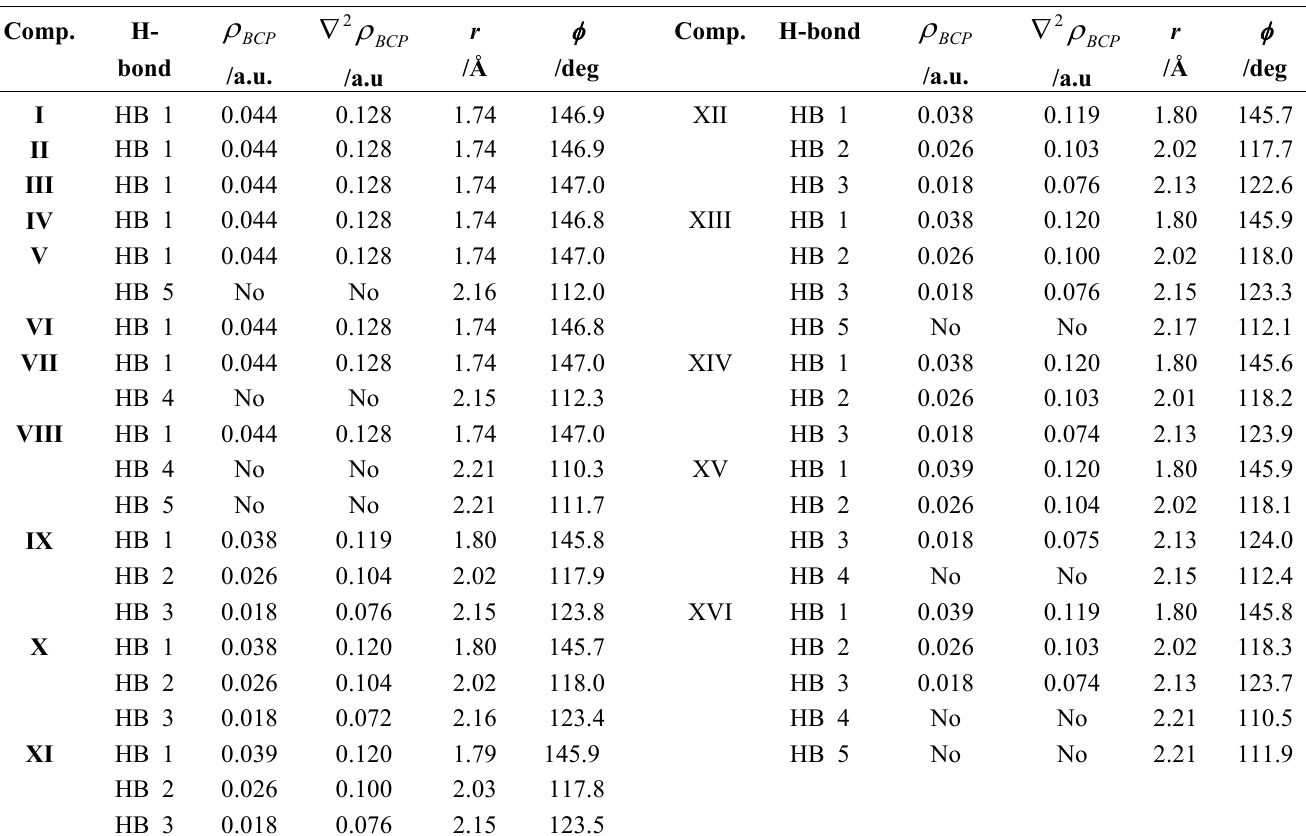
Table 4. AIM analysis of studied flavonoids monomers computed in gas phase at the ; Laplacian of electron B3LYP/6-311++G** theoretical level. Electron density at BCP, ρ BCP density at BCP,  2  ; donor–acceptor interatomic distance, r , and angle,  , for the BCP intramolecular H-bonds. Values calculated for optimized structures reported in Figure 2. Intramolecular H-bonding sites defined in Figure 4.  is defined ad D-H---A, where it stands for O-H---O(C) for HB_1 and HB_2, C-H---O(H) for HB_3, and O-H---H(O) for HB_4 and HB_5.